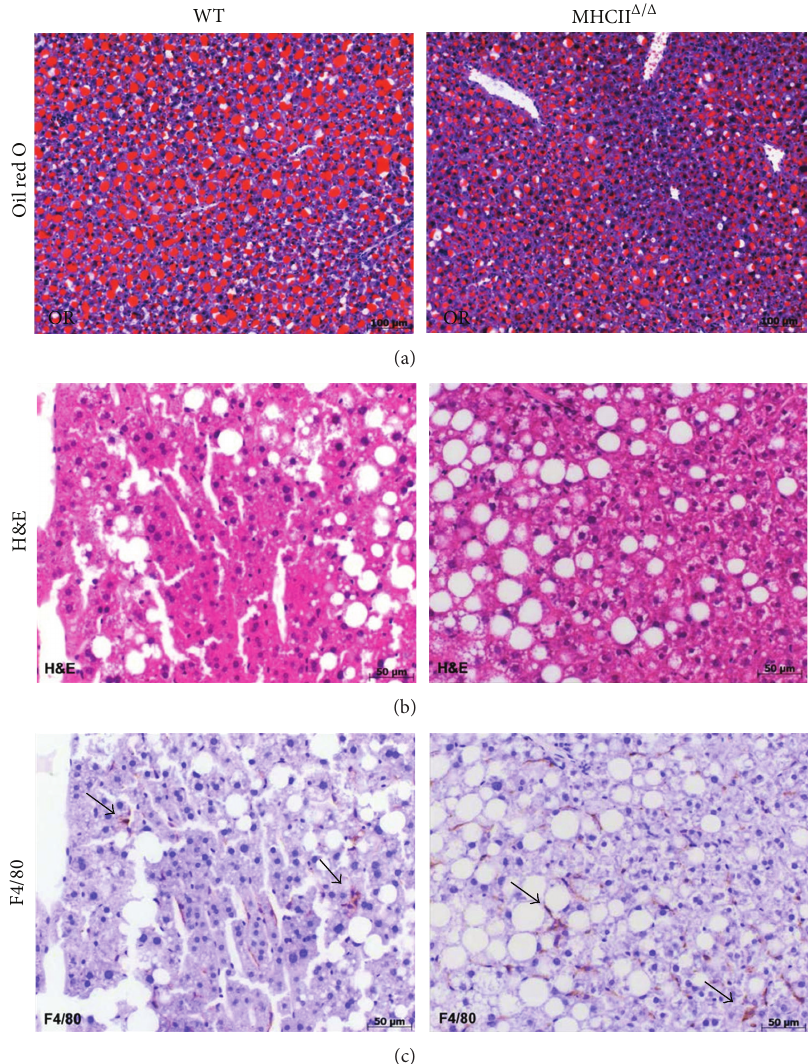
Figure 4: Effect of high-fat diet on liver histology in wild-type and MHCII Δ/Δ mice. (a) Oil red O staining (red color represents the lipid accumulation). (b) Hematoxylin and eosin (H&E) staining. (c) F4/80 immunohistochemistry (macrophages were stained in brown: